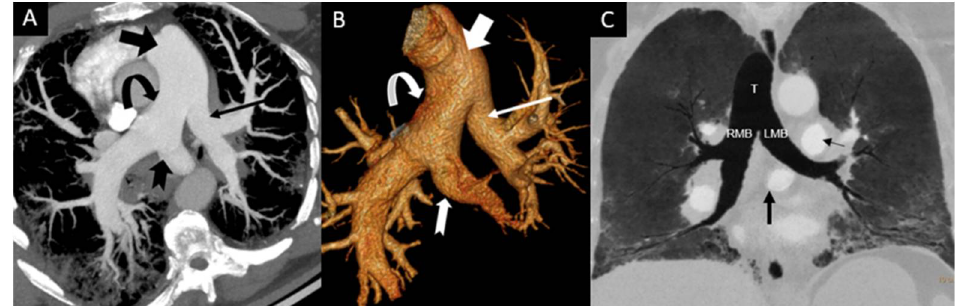
row), while an anomalous left lower lobe pulmonary artery (notched arrow) coursing inferior ante- rior to the left main bronchus and left lateral to the esophagus (star). No anomalous vessel was seen between the trachea and the esophagus. Right main bronchus is marked with a bold white arrow.